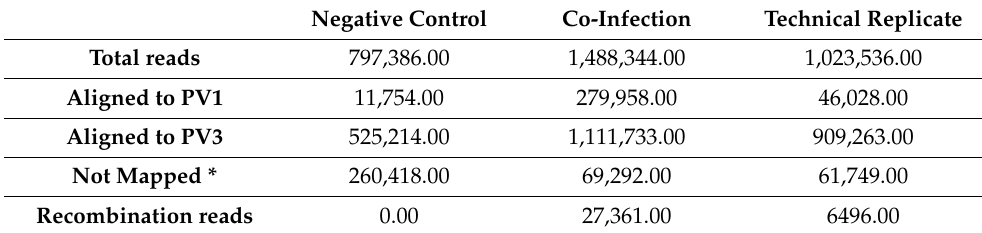
Table 1. Remaining reads to identify the recombination junction.